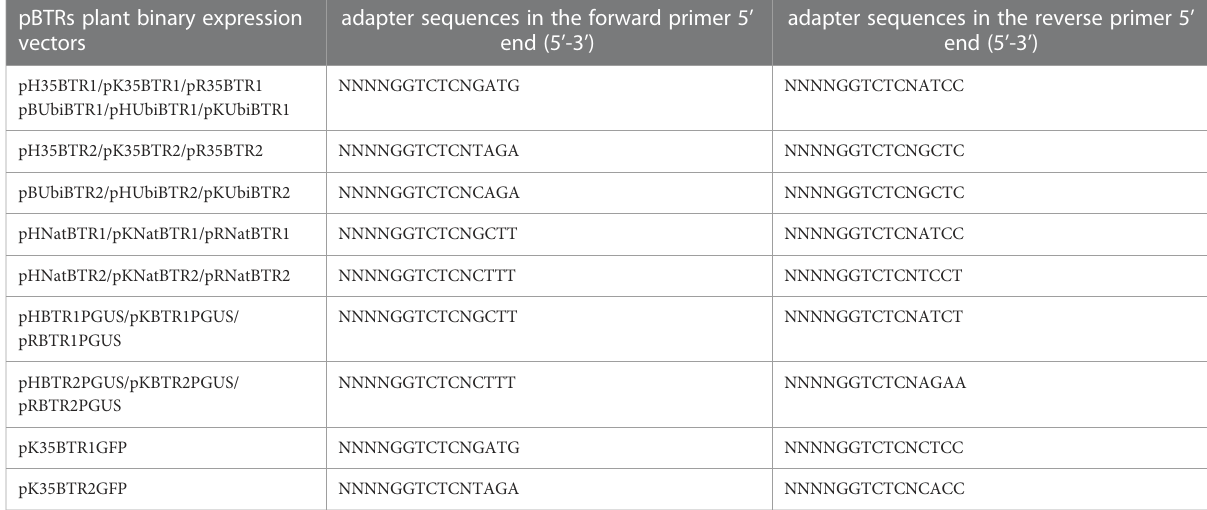
TABLE 1 Adapter sequences should be added in the primer 5 ’